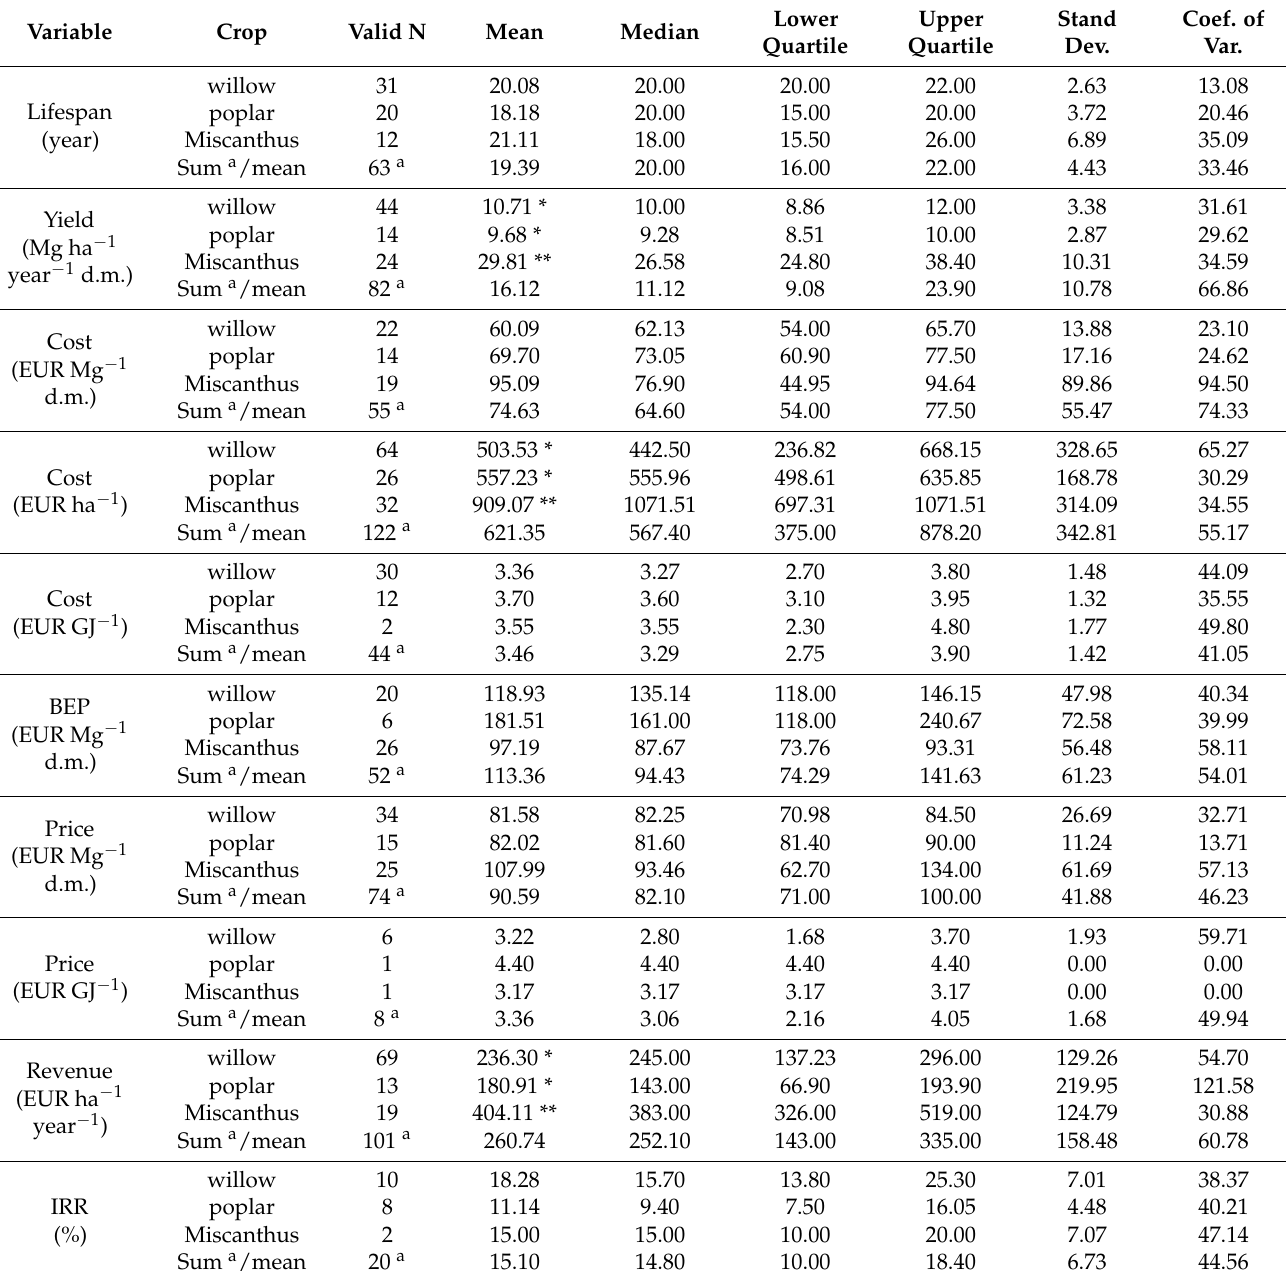
Table 1. Descriptive statistics of economic value indicators in the papers selected for